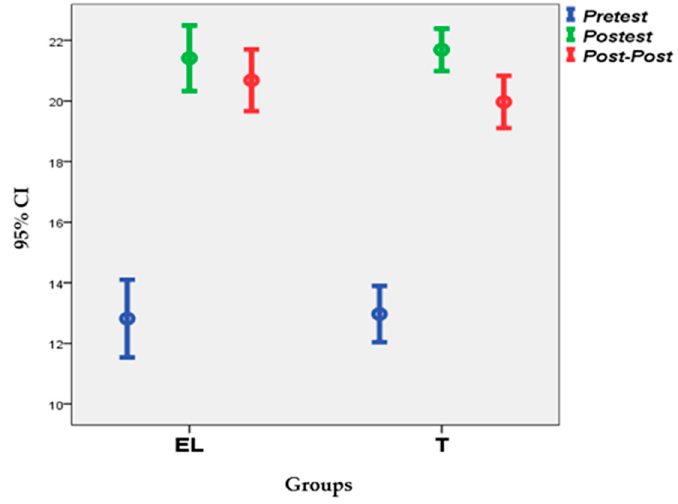
Figure 3. Knowledge test means and confidence intervals (95%).